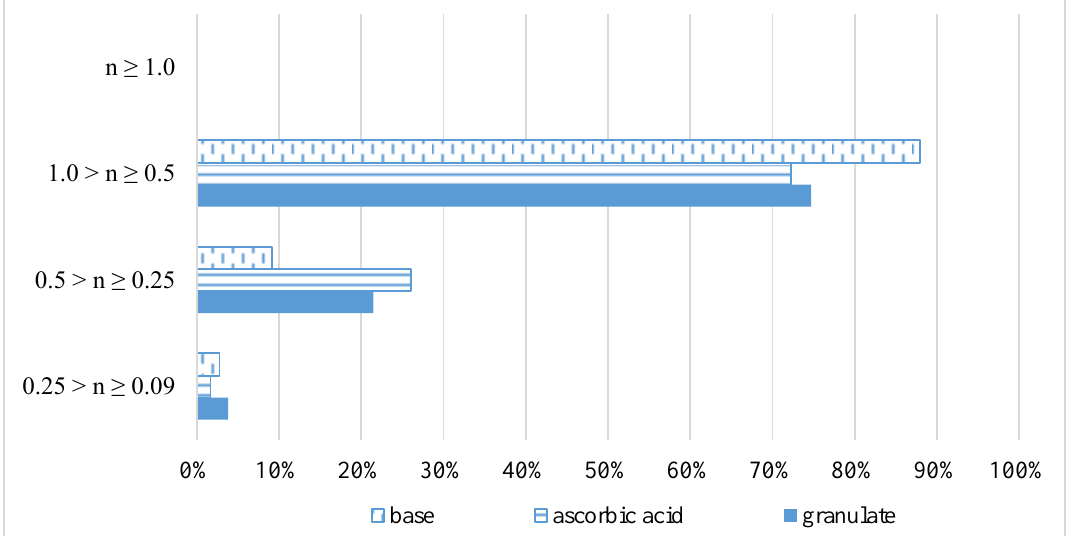
Fig. 5. The fractional composition of the resulting mass for pressing